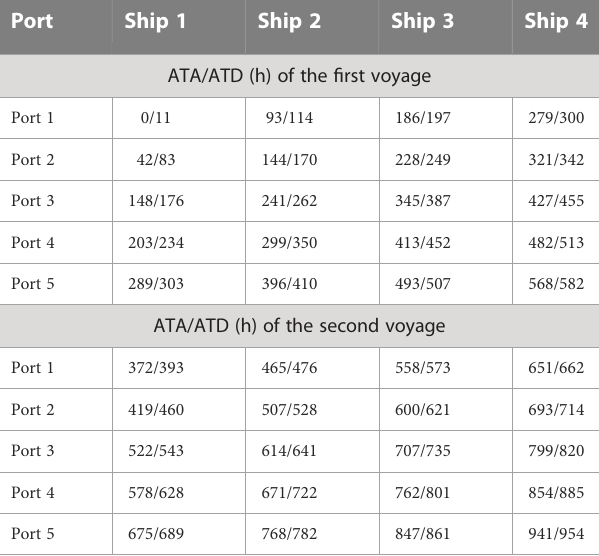
TABLE 10 ATA/ATD in the scenario under reference 1.